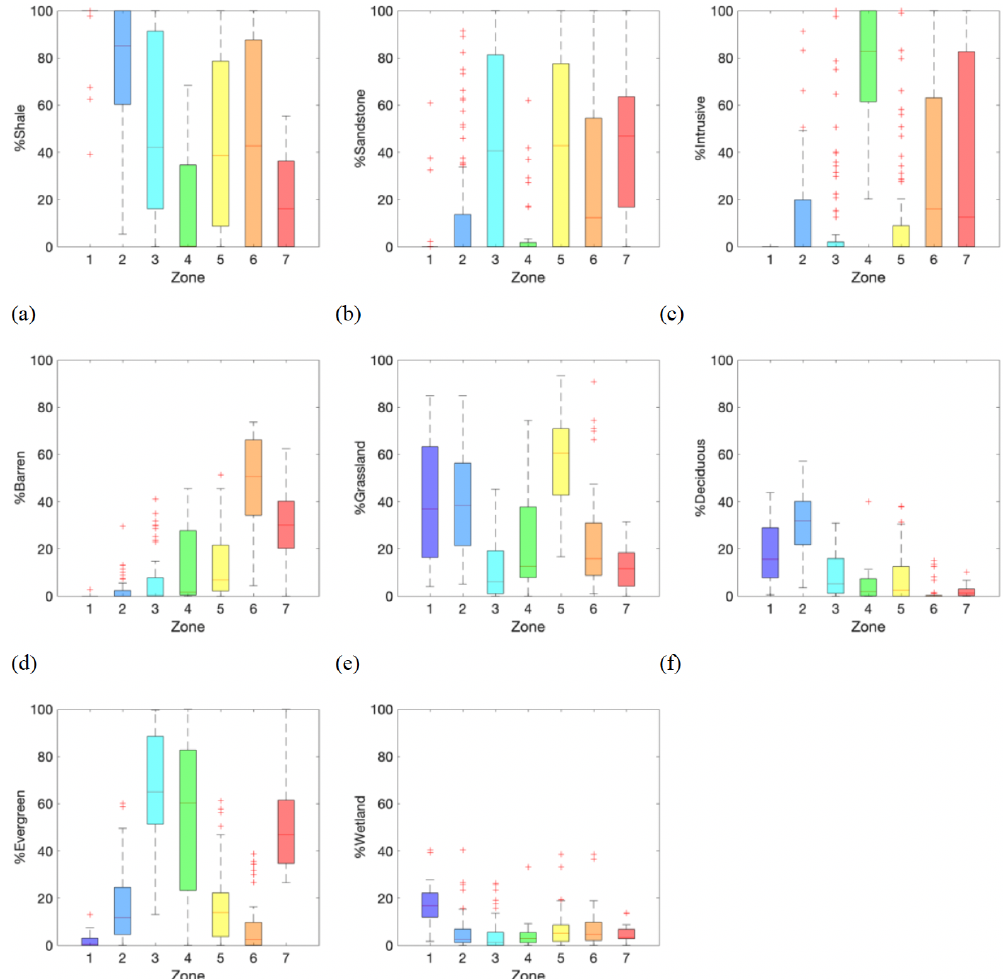
Figure 6. Box plots of hillslope pattern features with respect to geology and land-cover types: the percent coverage of (a) shale, (b) sandstone, (c) igneous (intrusive) rock, (d) barren, (e) grassland, (f) deciduous forest, (g) evergreen forest, and (h) riparian